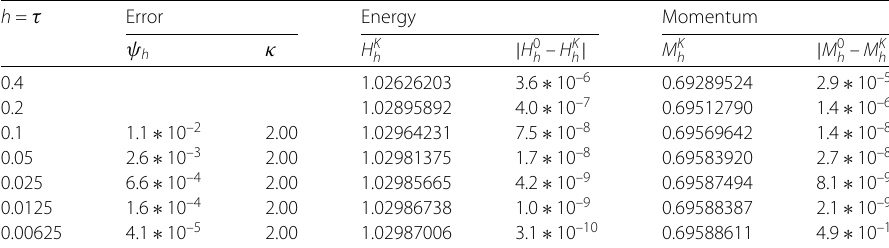
Table 3 Error, energy and momentum for Problem 2 using FDS-S h = τ Error